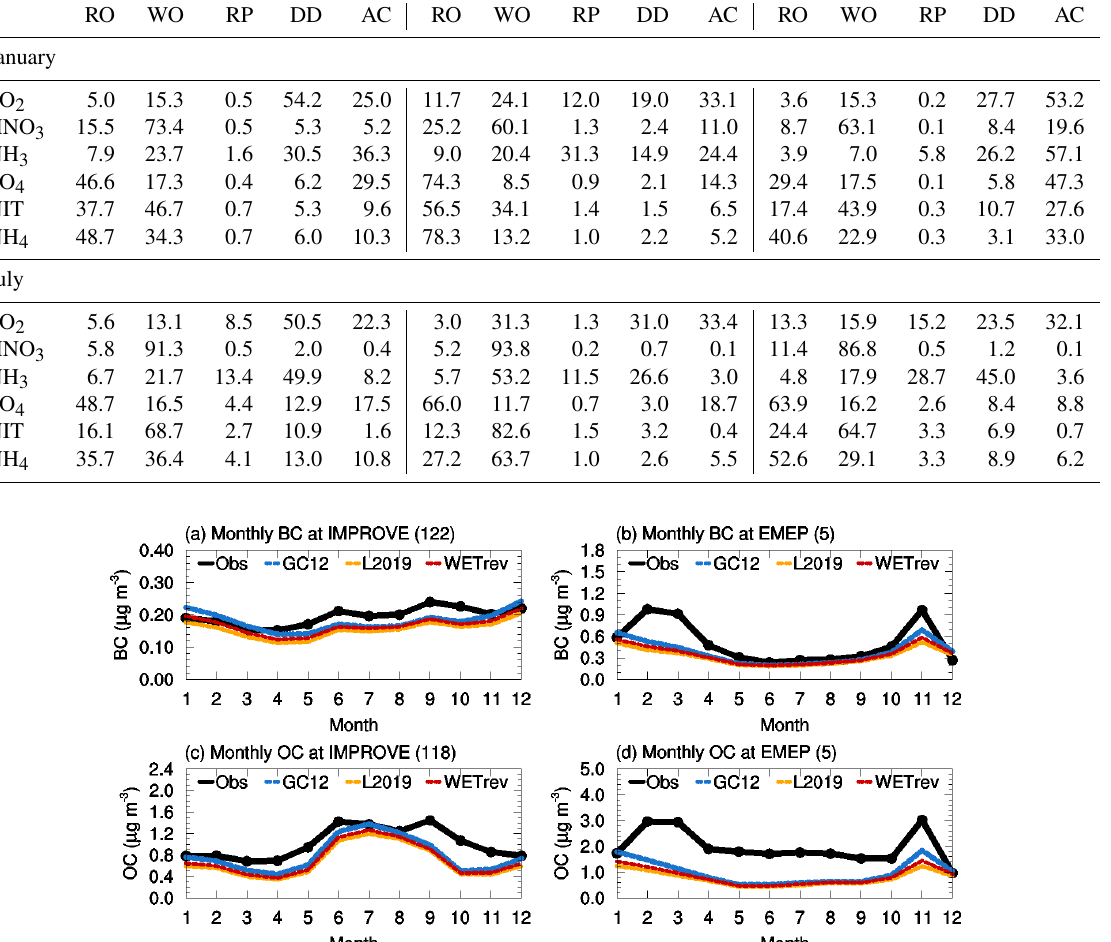
Figure 2. Variations of monthly means for the year 2011 showing the comparisons of black carbon and organic carbon surface mass concen- trations which are observed over (a, c) the US and (b, d) European sites (black) and simulated by GC12 (blue), L2019 (yellow), and WETrev (red) cases.